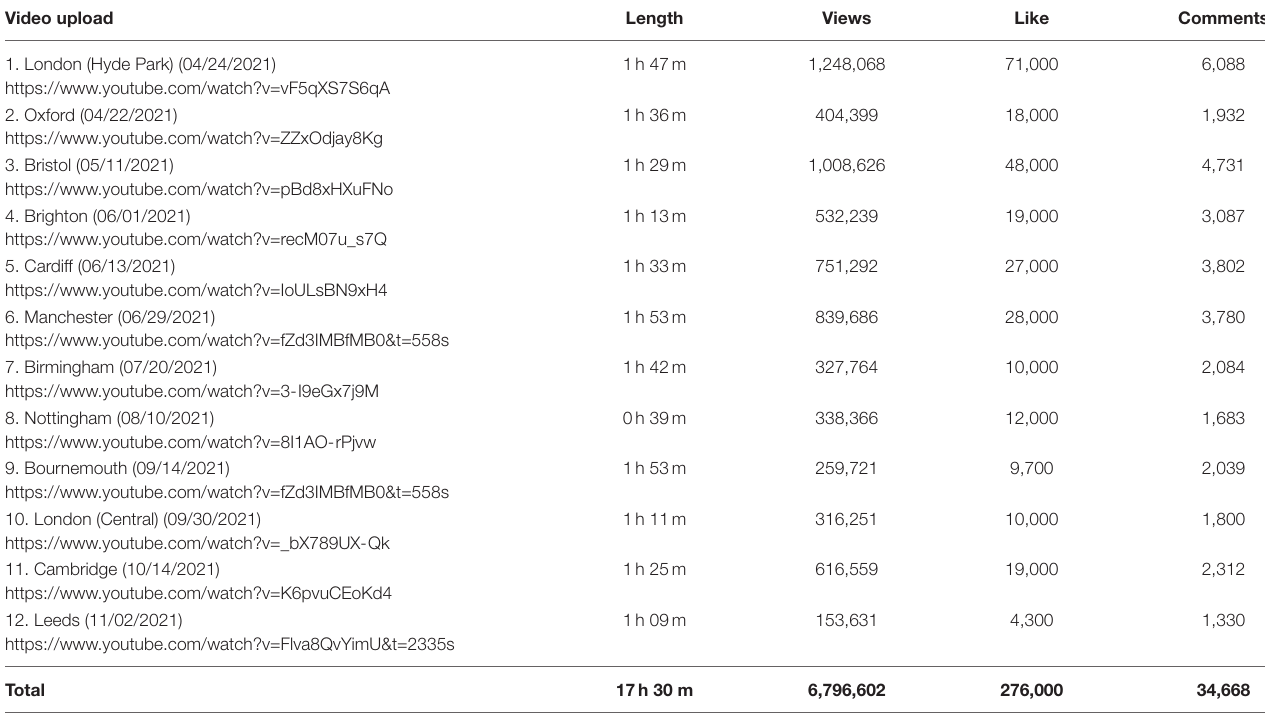
TABLE 1 | The drum and bass on the bike rides (information correct as of January 31st, 2022). Video upload